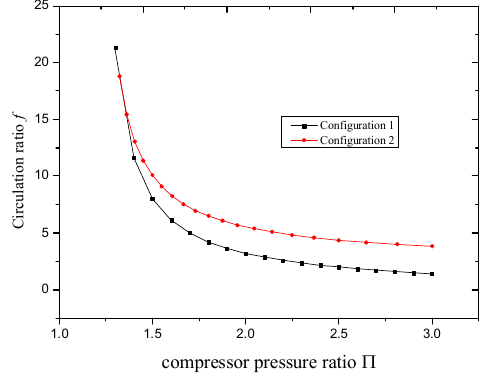
Figure 16. Circulation ratio f versus π at T GEN = 100 °C .